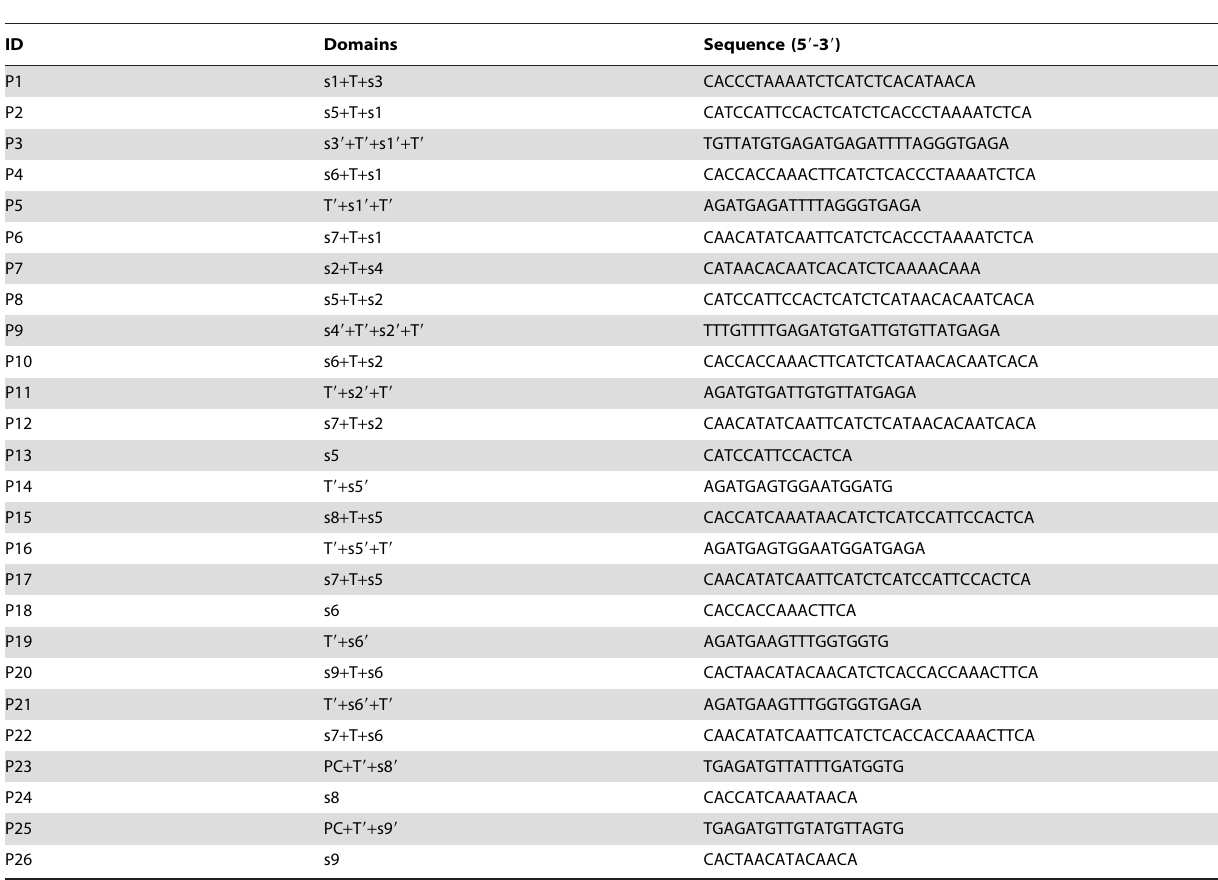
Table 2. All Oligonucleotides for ‘‘DNA